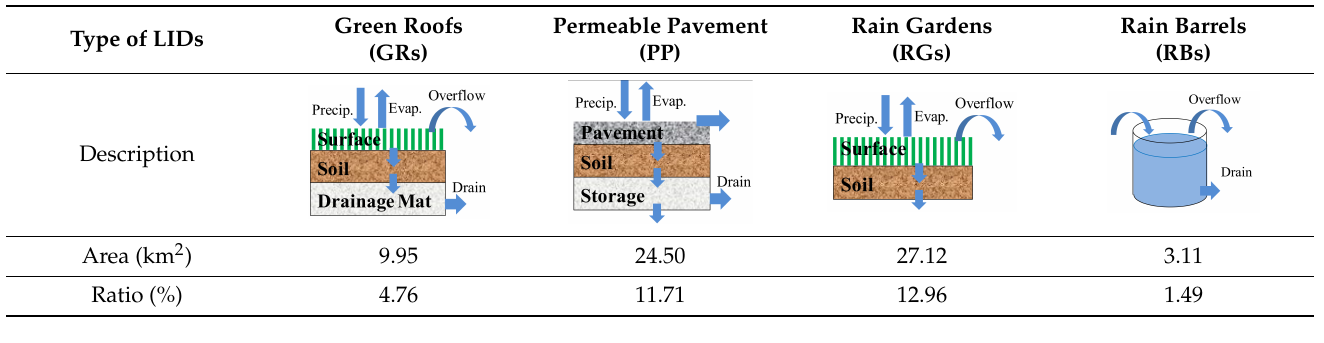
Table 3. Type of LIDs and Coverage.